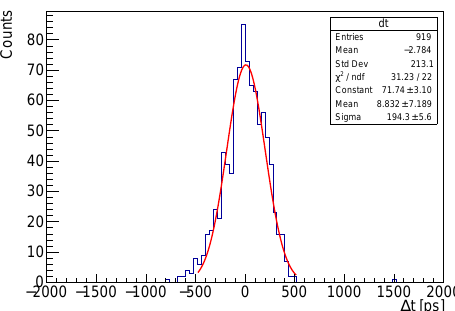
Figure 5. Coincidence time spectrum of annihilation gammas from 22 Na, detected by a 3 × 3 × 3 mm 3 LYSO crystal and a crystal from GaGG Module I operating at V OV = 4 V.